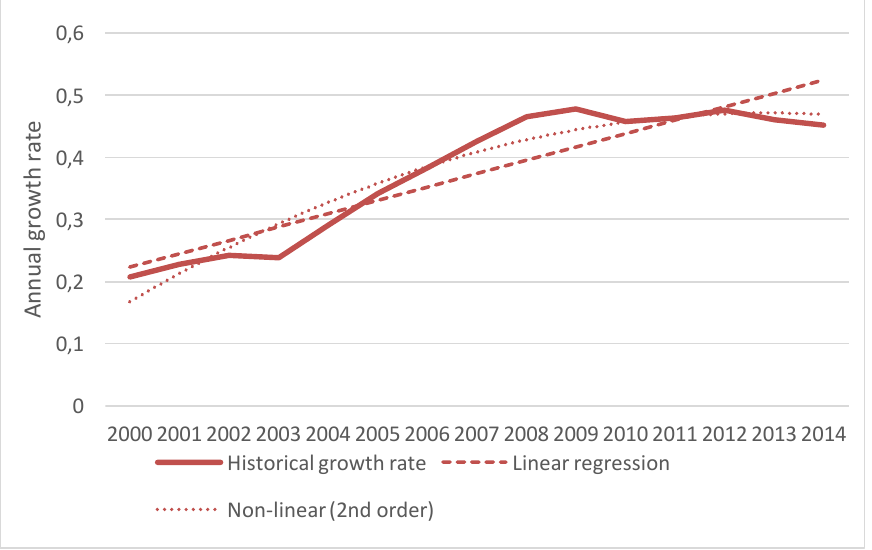
Fig. 4. The changes in Finnish population annual growth